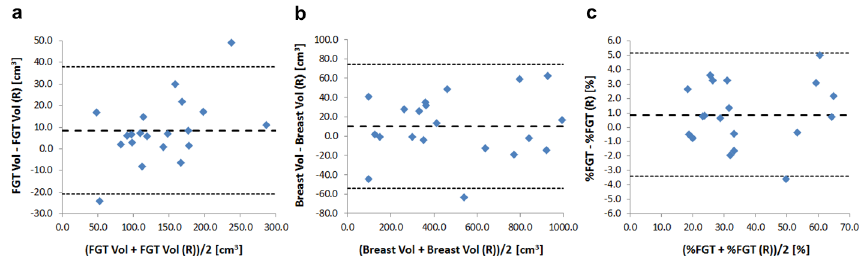
Fig 2. Bland-Altman plots for repeat high-resolution GRE PD-weighted measurements (HR GRE PD & HR GRE PD (R), respectively). a) FGT volume [cm 3 ]; b) Total breast volume [cm 3 ] and c) %FGT [%]. Mean differences and limits of agreement are represented by the central and outer dashed lines,